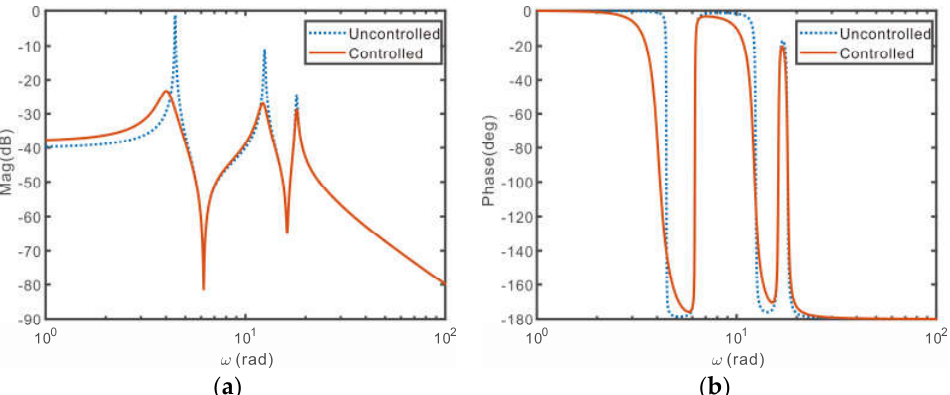
Figure 13. The bode diagram of the closed-loop system. ( a ) Magnitude; ( b ) Phase.